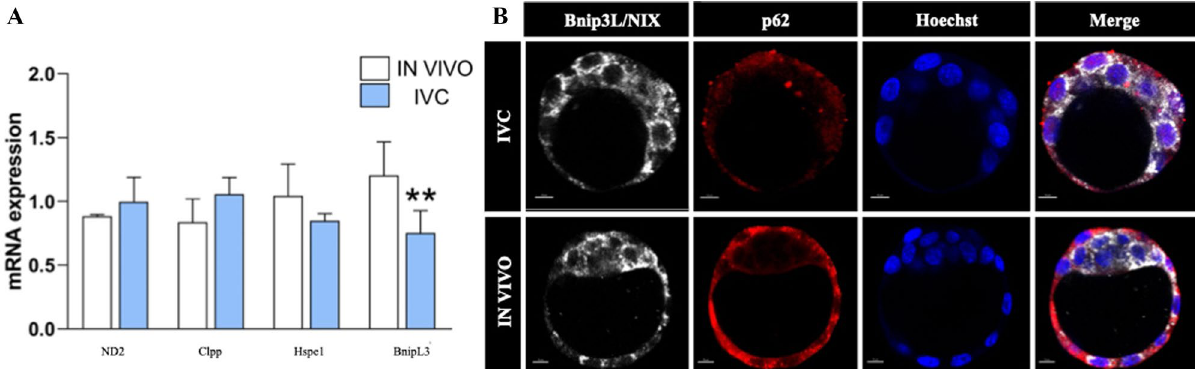
Figure 6. Expression of selected genes and proteins involved in mitochondrial function and mitophagy. ( A ) genes involved in mitochondial protein quality control (Clpp and Hspe1), electron transport chain (mtND2) and mitophagy (BnipL3) **p = 0.0018; ( B ) Protein expression of BnipL3 and p62 in IVC and IN VIVO blastocysts. Scal bars: 10